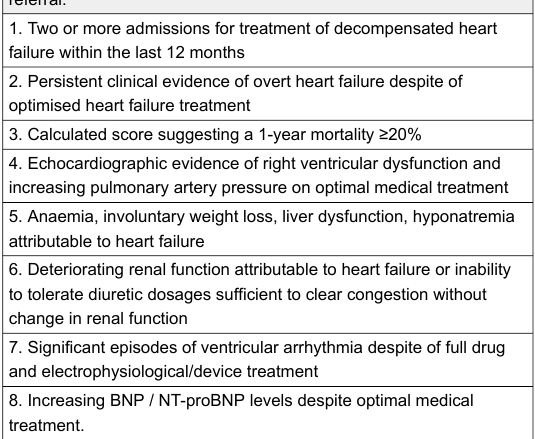
Table 2: Clinical indicators that should prompt consideration for